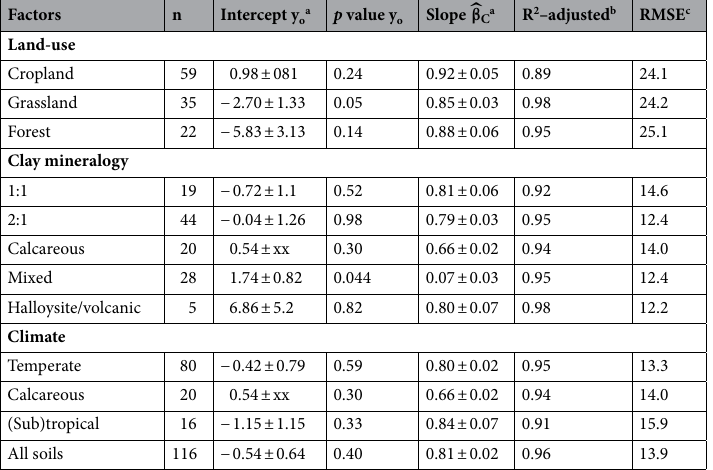
(cid:31) β C ω, where y is the SOC (cid:31) β C were